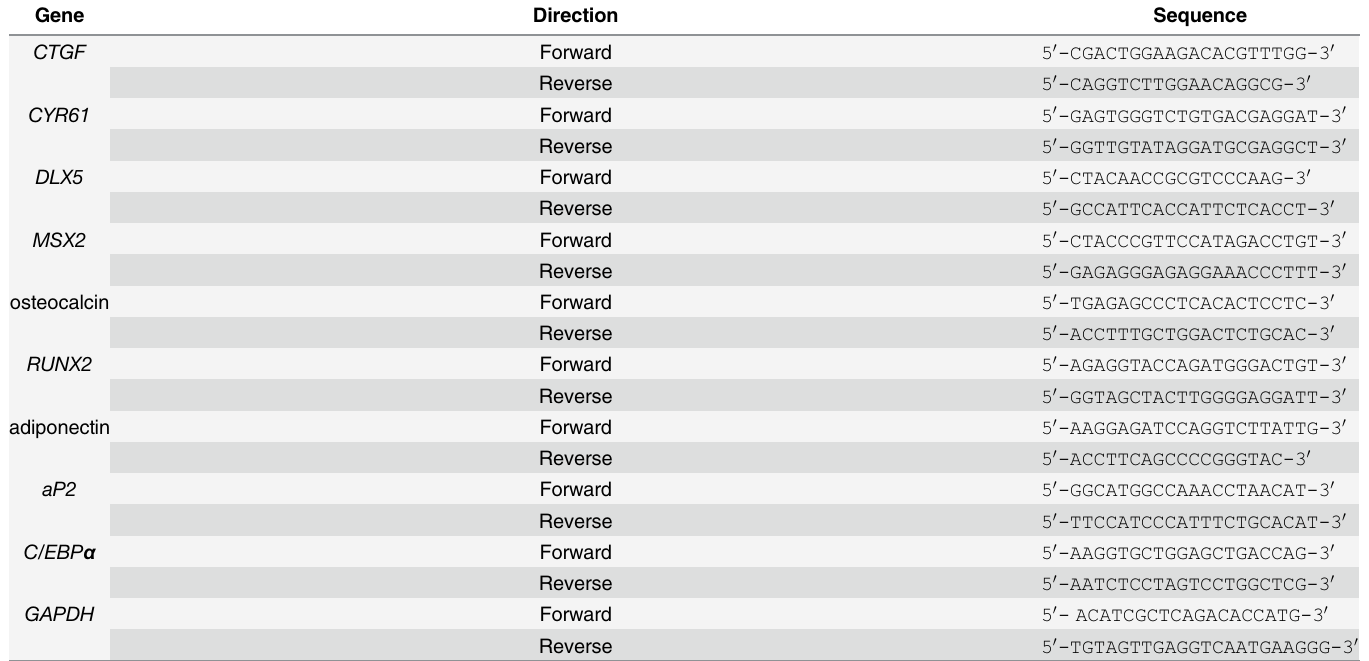
Table 1. Primers for